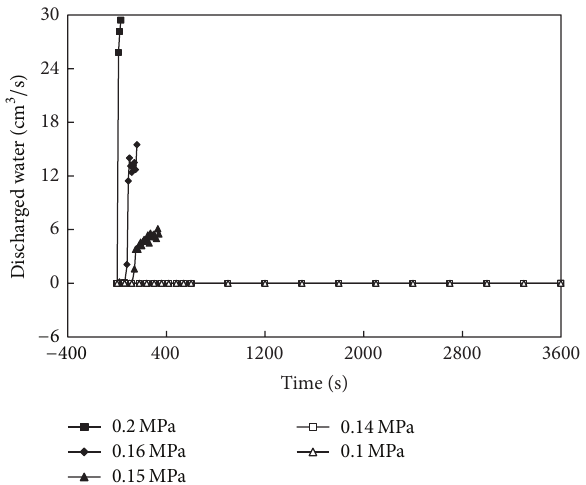
Figure 4: Relationship between discharged water and tested time of filter cake 2.